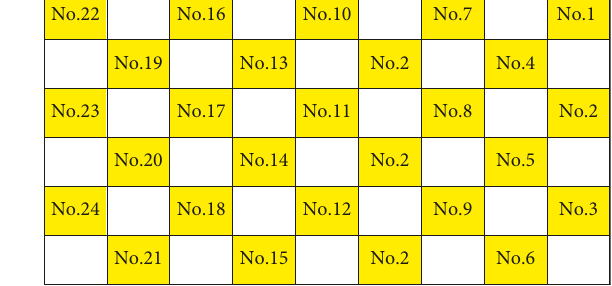
Figure 2: Rectangular aperture.